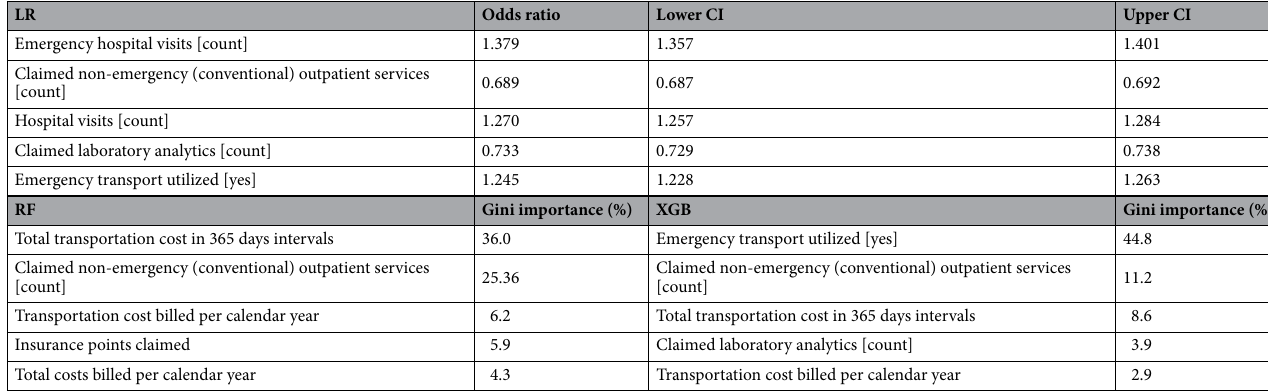
Time distance [years] Balanced accuracy F1-score (weighted) Sensitivity Specificity